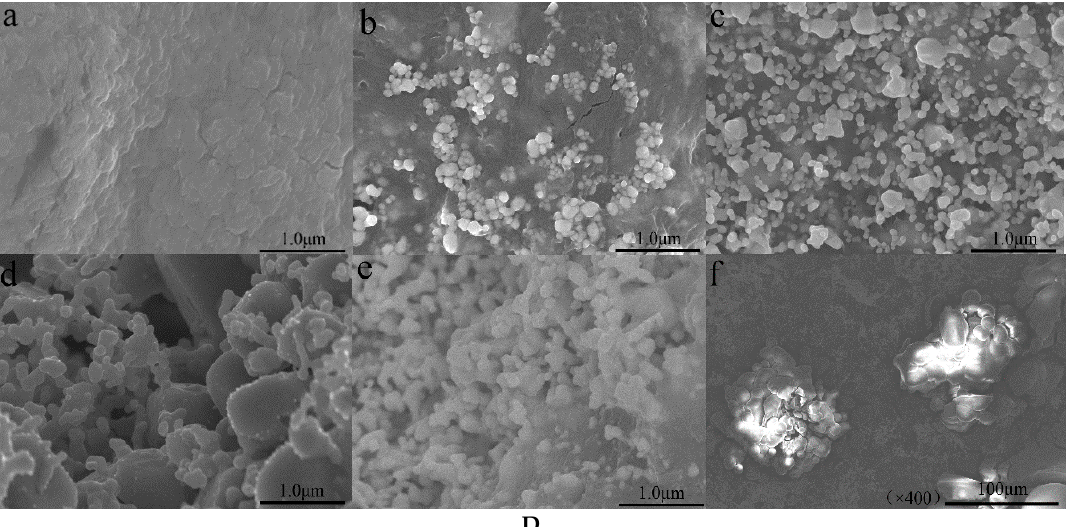
Figure 1. ( A ) SERS spectra of 10 − 4 M R6G detected with CF-Ag prepared with 6, 12, 15, and 18 mM AgNO 3, and CF (spectrum above is the average of five measurements); ( B ) Peaks at 1508 and 1647 cm − 1 in the SERS spectra shown in A; ( C ) (a–e) TEM images of CF, CF-Ag-6, CF-Ag-12, CF-Ag-15, and CF-Ag-18 (“6, 12, 15, 18” indicates that 6 mM, 12 mM, 15 mM, and 18 mM AgNO 3 were used, respectively) and (f) UV adsorption spectra of CF-0 (Black), CF-Ag-6 (Bright red), CF-Ag-12 (Blue), CF-Ag-15 (Green), and CF-Ag-18 (Plum Purple). ( D )SEM of images of (a) CF, (b) CF-Ag-6, (c) CF-Ag-12, (d) CF-Ag-15, (e,f)and CF-Ag-18. (×30,000 with (a–e), and ×400 with (f)).